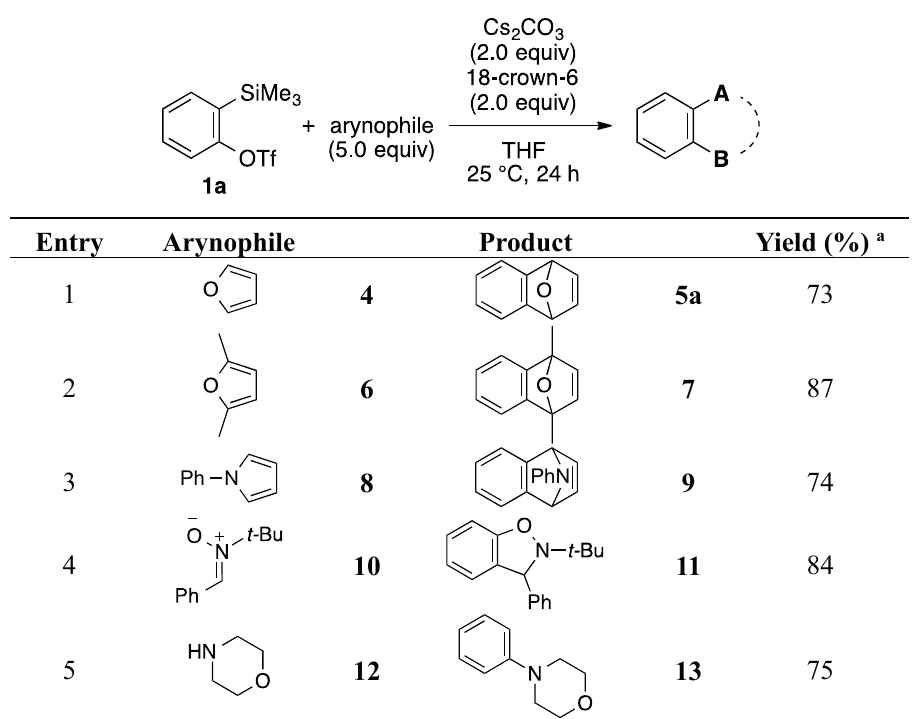
Table 2. Reactions of benzyne generated from 1a with various